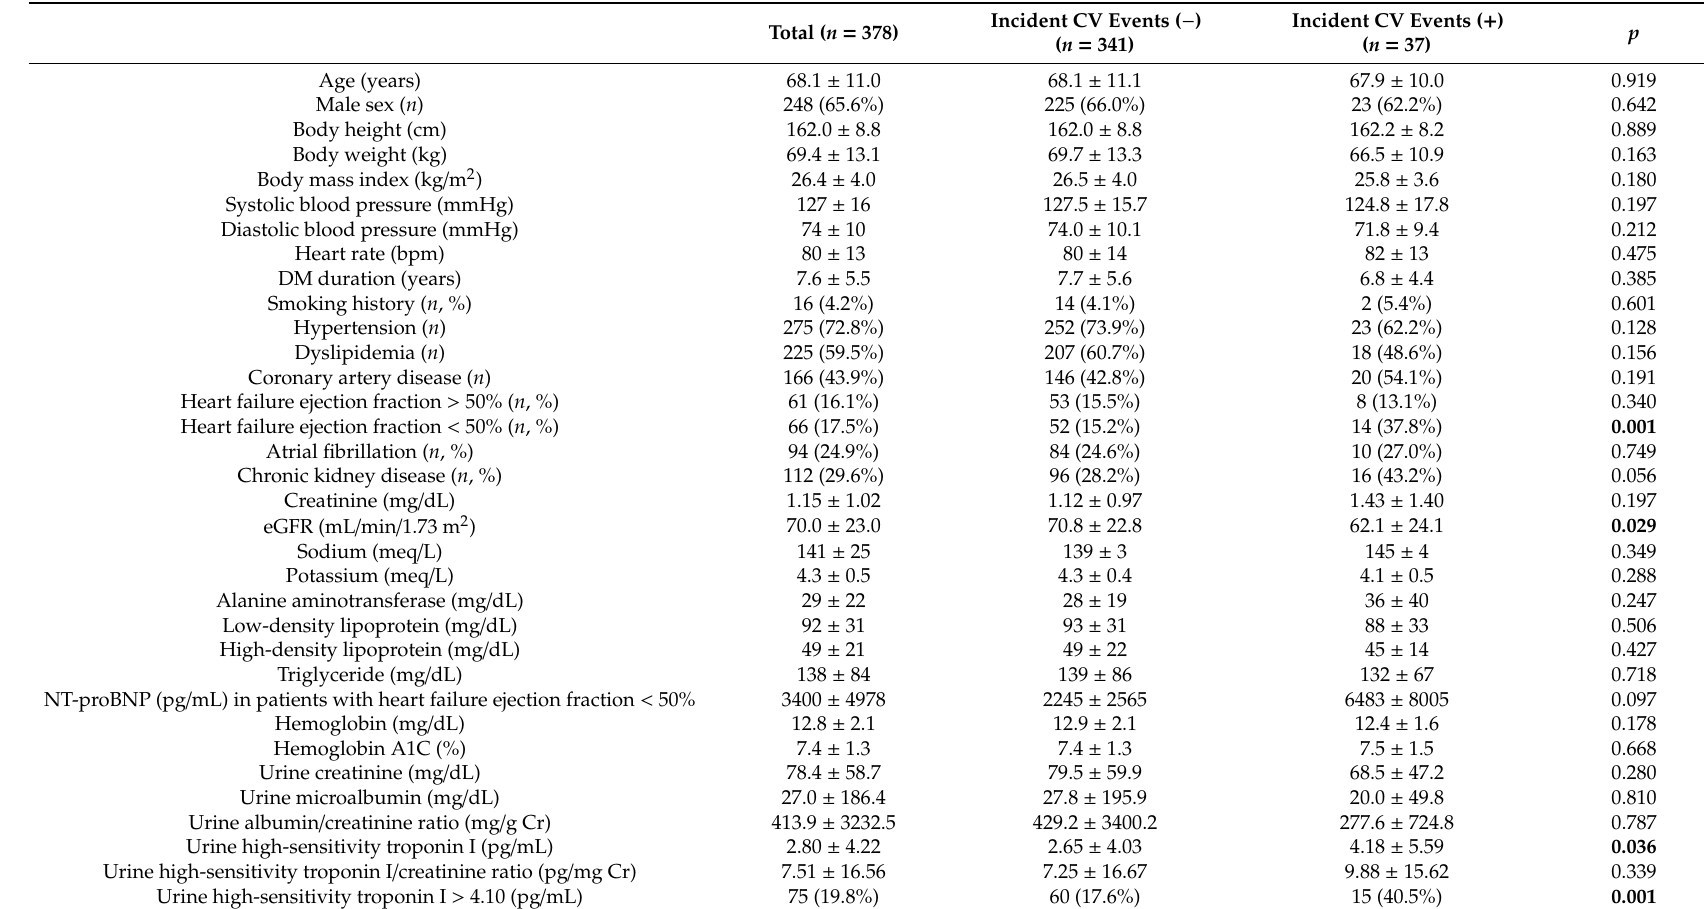
Table 1. Baseline characteristics of the patient